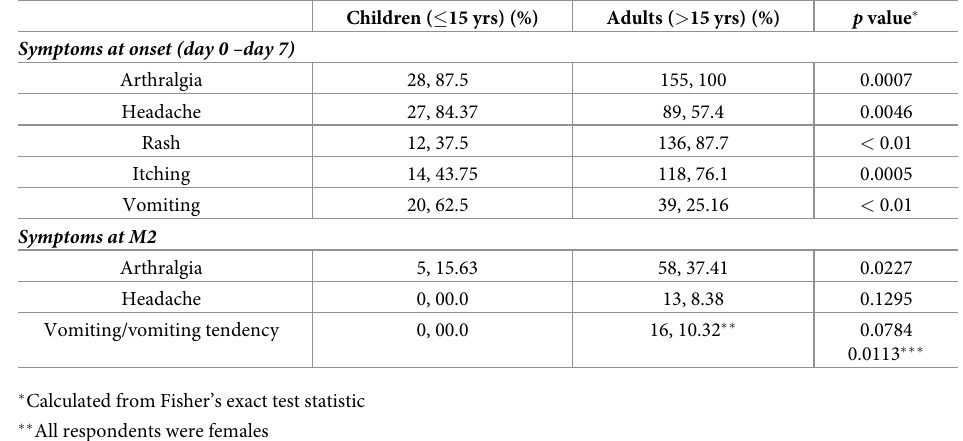
Table 4. Differences in clinical manifestations of CHIKV positive children and